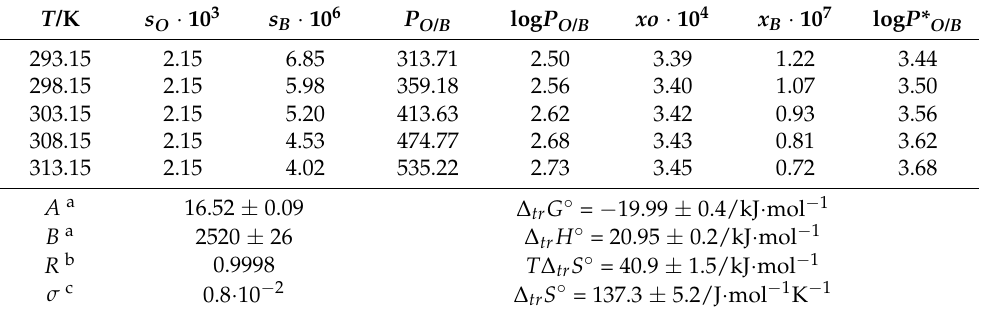
Table 8. Experimental concentrations, partition coefficients and transfer thermodynamic parameters of IVZ in the 1-octanol/buffer pH 7.4 system at different temperatures and pressure p = 0.1 MPa. T /K s O · 10